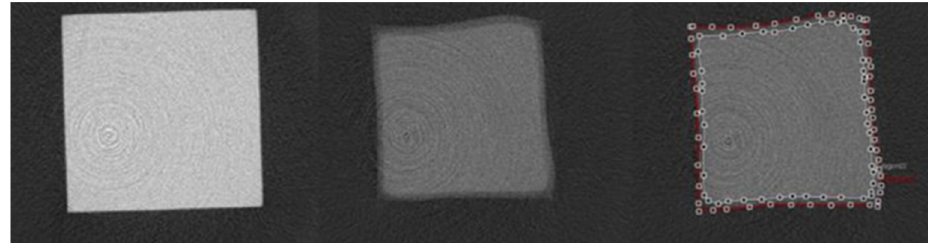
Figure 7. Axial view of micro computed tomography images within the resin–dentin interface of representative total-etch resin–dentin bonded specimens after 7 days of incubation in media con- taining S. mutans and L. rhamnosus . Left: µCT image of intact resin, 21.25 µm above the interface; Middle: µCT image of demineralized/cavitated dentin, 42.5 µm below the interface; Right: µCT image of interface with areas of demineralization (white line) and cavitation (red line) [78].